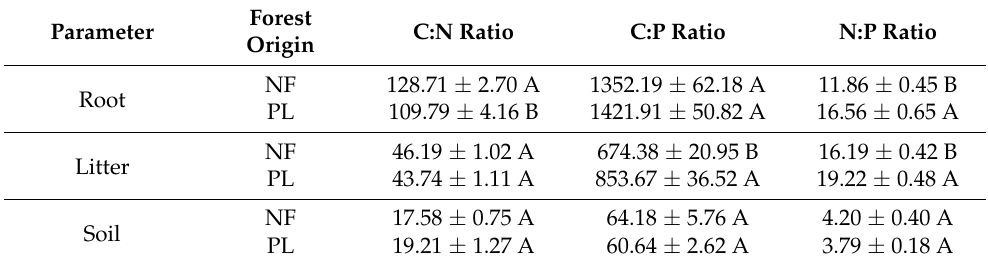
NF (Table 2, p < 0.05). By comparison, the C:N and C:P ratios in NF and PL only significantly differed in roots and litter (Table 2, p < 0.05), respectively. Table 2. Stoichiometry of the C, N, and P in roots, litter and soil in NF and PL in forest ecosystems in